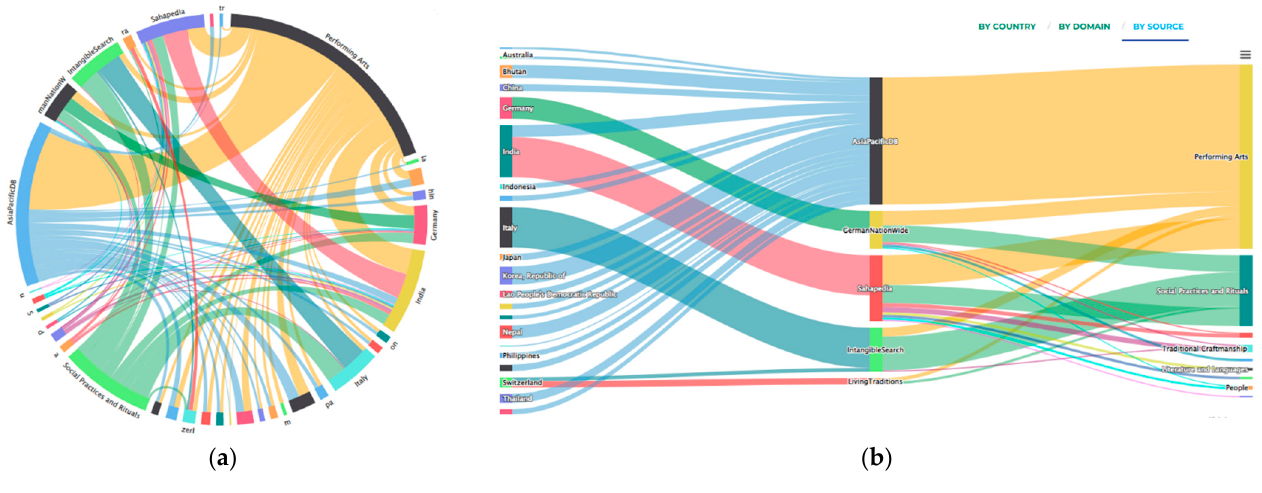
Figure 14. Results for theme “Traditional dances”: ( a ) dependency wheel graph; ( b ) Sankey graph.